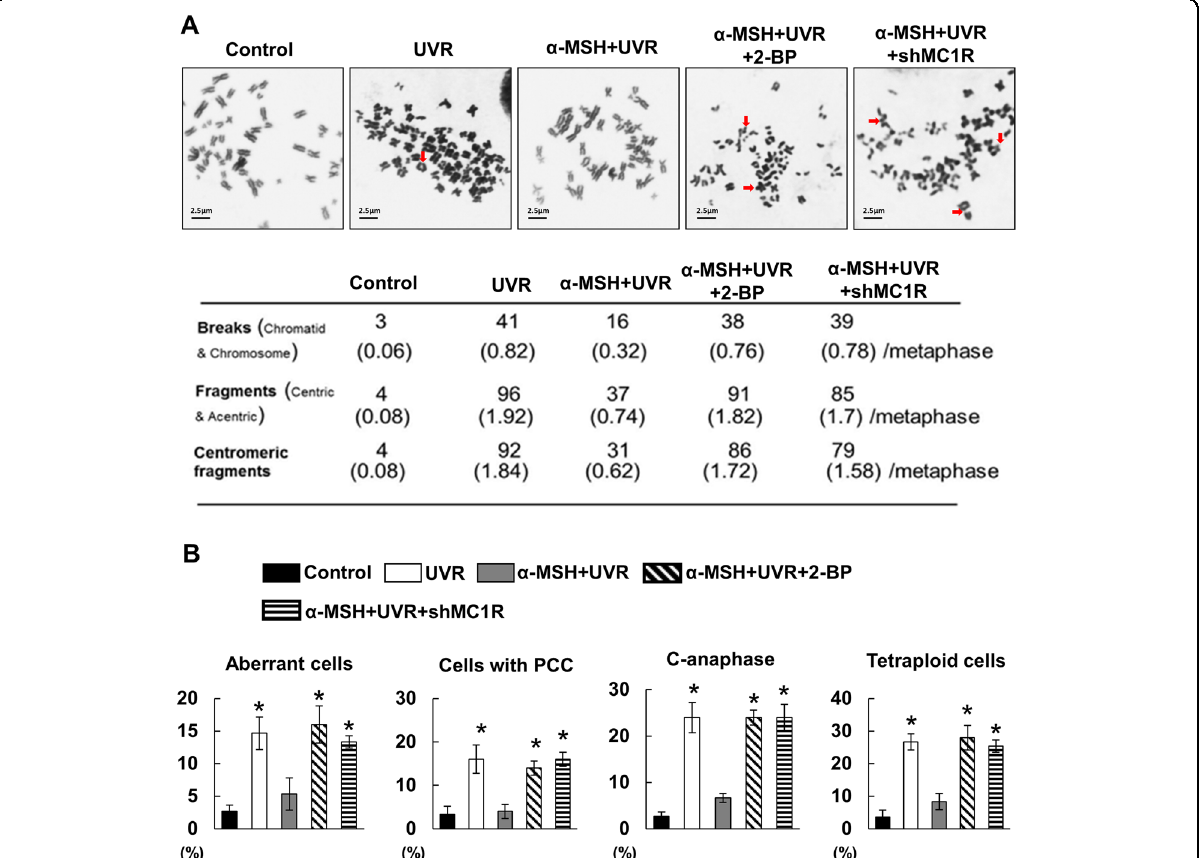
Fig. 1 The role of α -MSH/MC1R in the prevention of UVR-induced chromosomal instability and centromere fragmentations in HPMs. A Chromosome was analyzed in HPMs stimulated with or without MSH ( n = 84). Low panel: centromeric fragments were counted as indicated. B Multiple cytogenetic abnormalities as indicated were counted in metaphase spread in